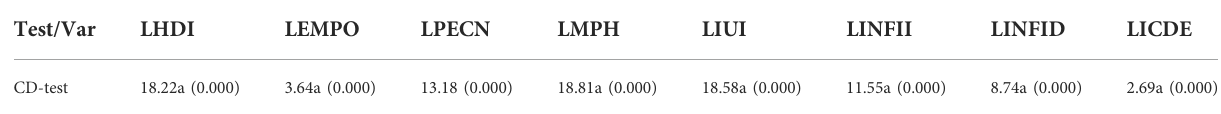
TABLE 3 Cross-sectional dependence test.